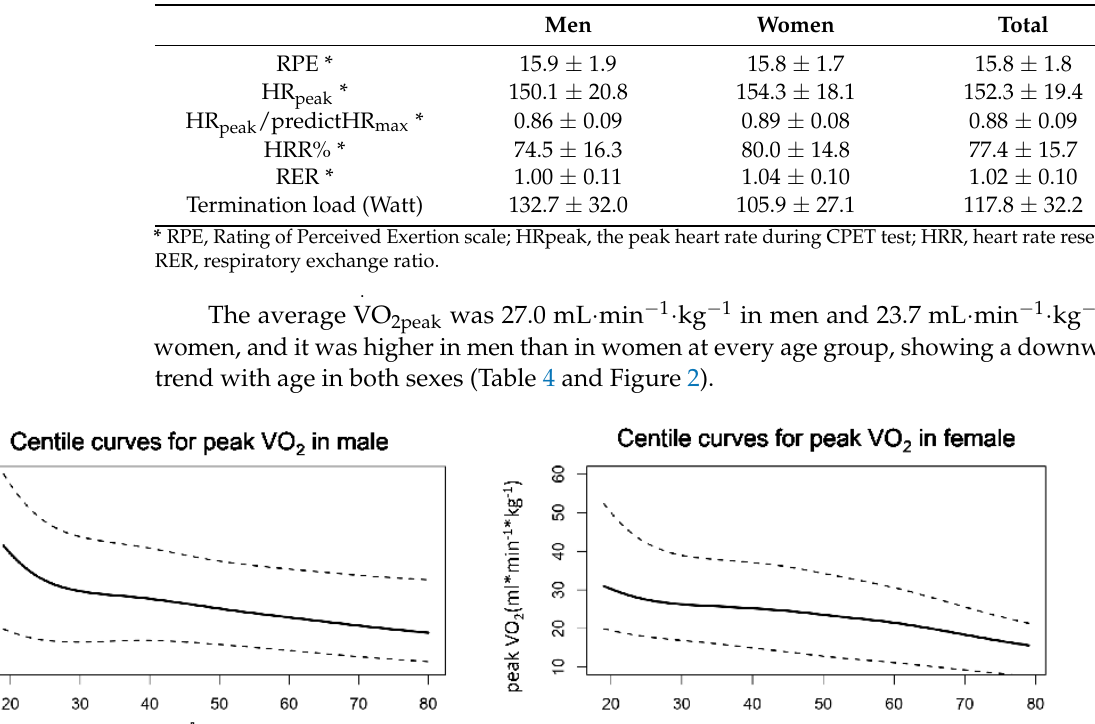
Table 3. CPET responses at maximal effort in men and women.